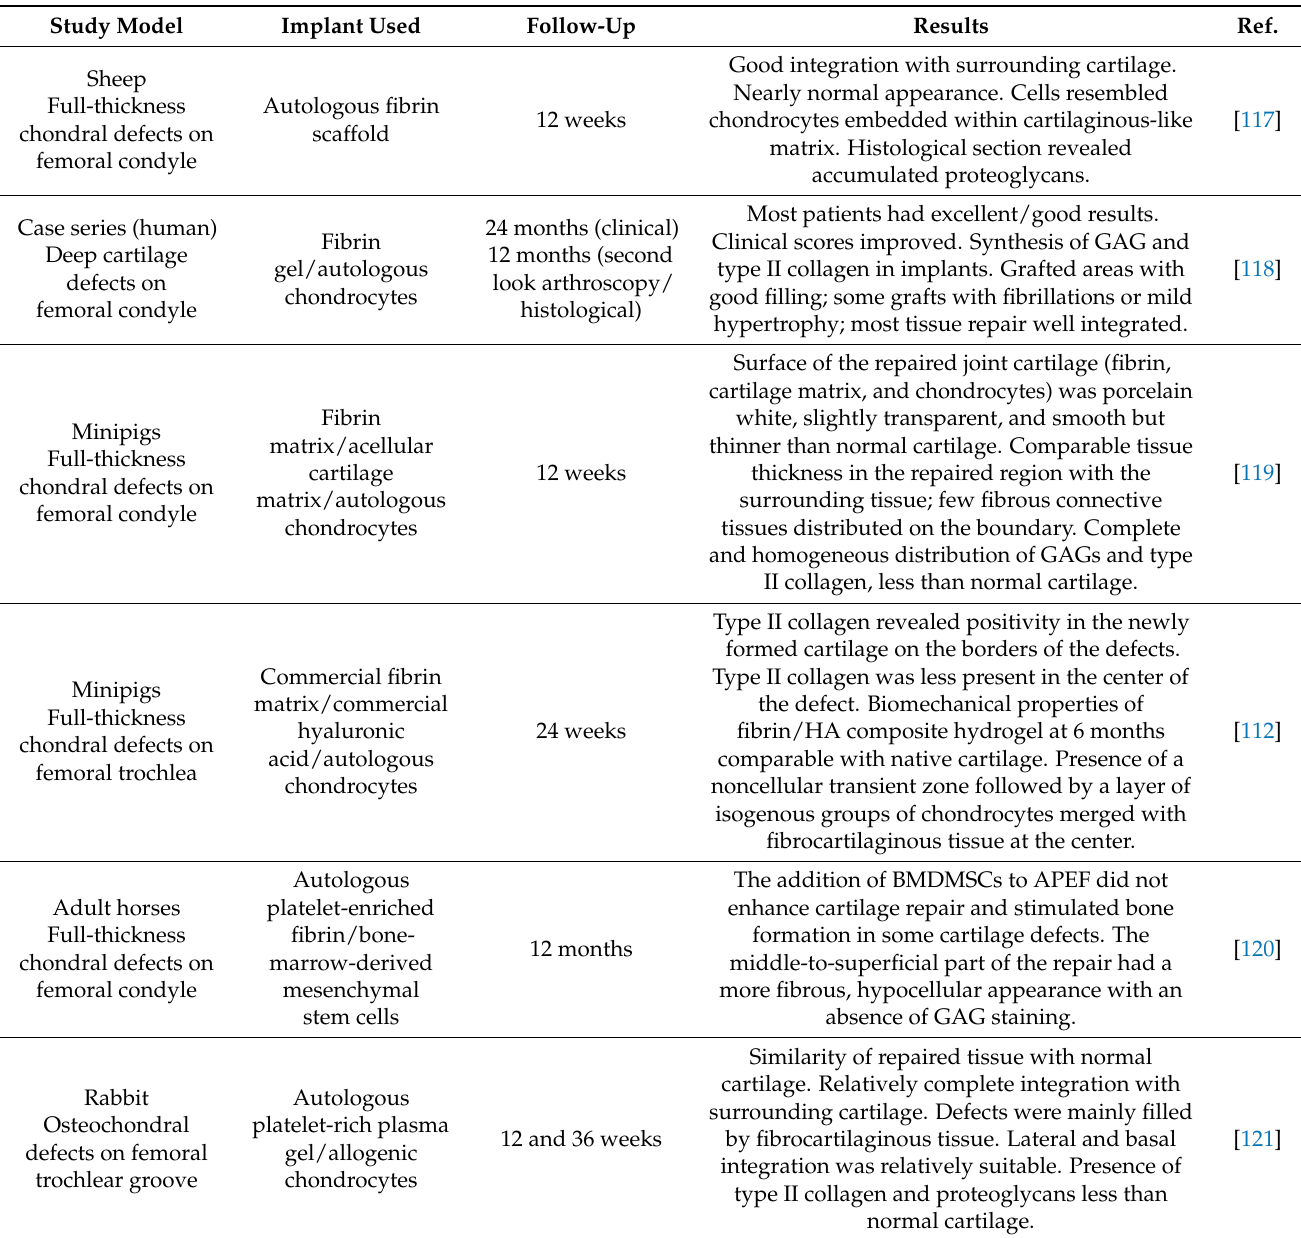
Table 4. Examples of in vivo studies of fibrin scaffold for regeneration or repair of chondral